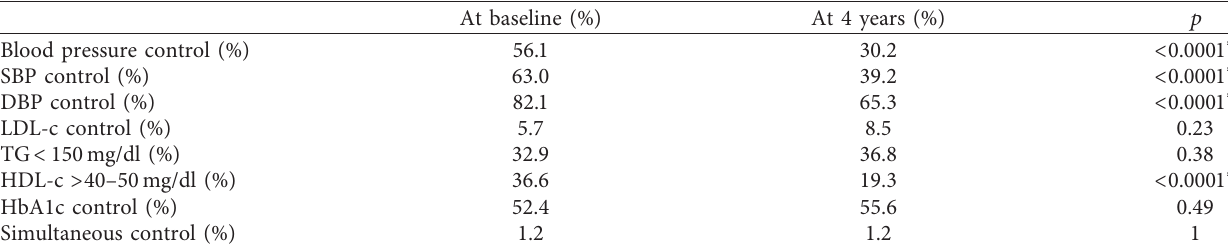
Figure 2: Change in the number of controlled risk factors overtime. Table 2: Control rate of individual risk factor at baseline and final follow-up according to 2018-2019 guidelines on hypertension and diabetes from European Society of Cardiology.